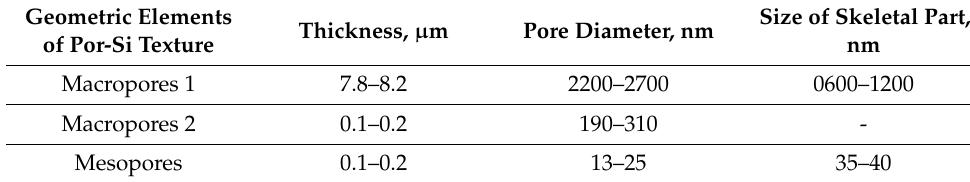
Table 1. Parameters of meso-macroporous silicon